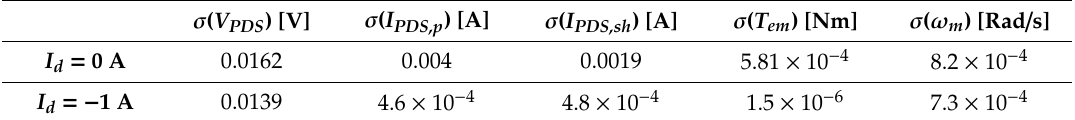
Table 10. Standard deviations at the first working point for di ff erent I d values.